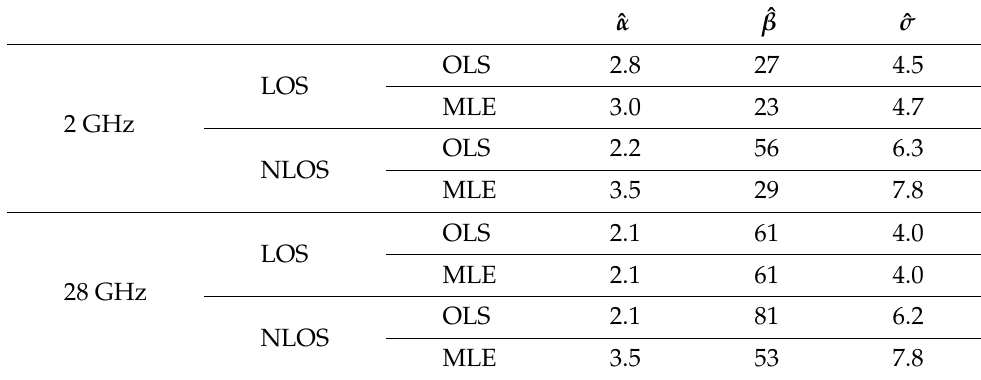
Figure 4. Fitting the path loss model to the training data with OLS (green) and MLE (red); Example 3, 2 GHz LOS, 2 GHz NLOS, 28 GHz LOS, 28 GHz NLOS. Training data with PL under the noise threshold are shown with black dots, solid lines show PL ( d ) , and the dash lines are PL ( d ) ± 1.96ˆ σ . Table 2. Fitted OLS and MLE parameter estimates for Example 3 at 2 and 28